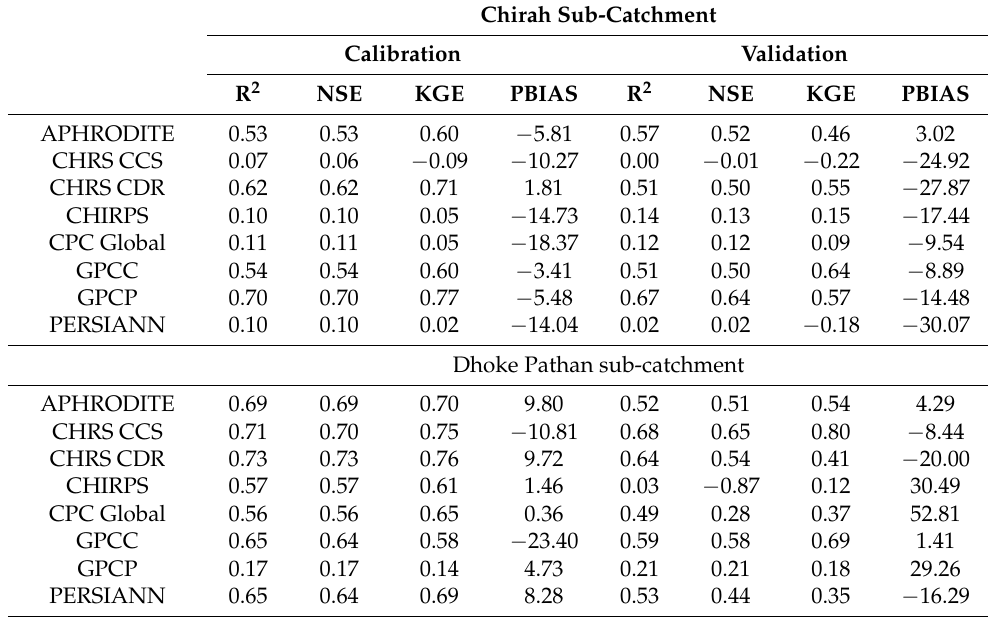
Table 2. Performance of eight PPs in simulating daily streamflow for Chirah and Dhoke Pathan sub-catchments.